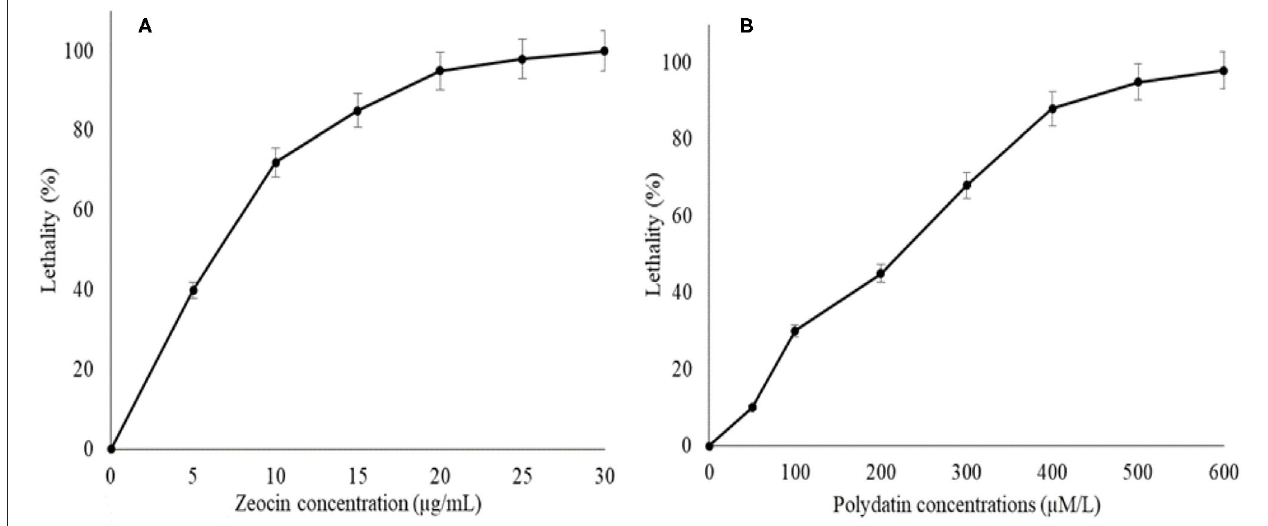
FIGURE 1 | The lethal rates curves of SW1 cultured in agar plates containing; (A) 0, 5, 10, 15, 20, 25, and 30 µ g/mL zeocin as well as (B) 0, 50, 100, 200, 300, 400, 500, and 600 µ M/L of polydatin, respectively. Values and error bars represent the means and the standard deviations of triplicate experiments ( n =